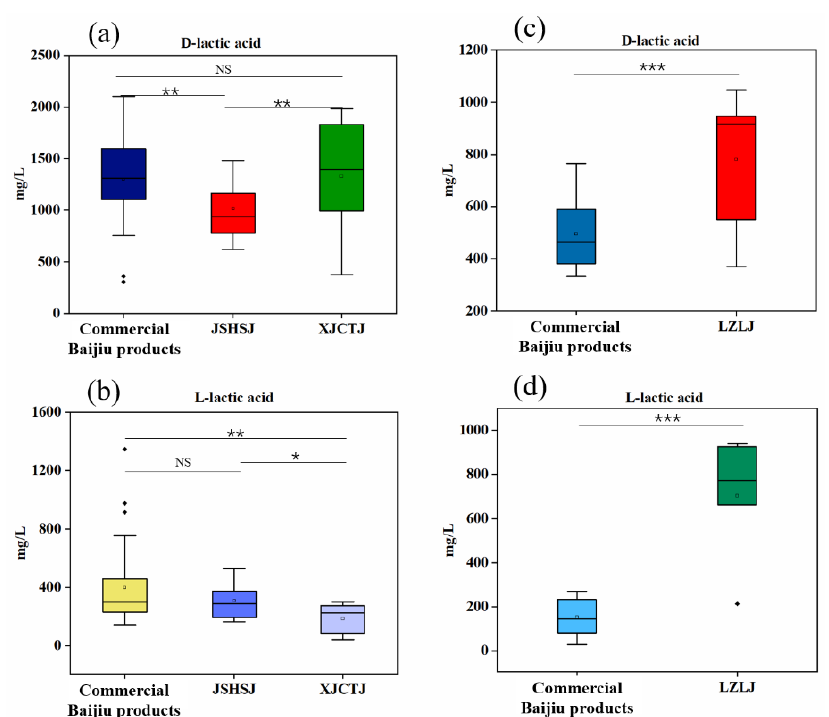
Figure 5. ( a , b ) Box plots of D-lactic acid and L-lactic acid contents in three different types of Baijiu (Commercial Baijiu products, JSHSJ, XJCTJ) in SSB; ( c , d ) box plots of D-lactic acid and L-lactic acid contents in two different types of Baijiu (Commercial Baijiu products, LZLJ) in STB. t-test: NS (not significant, p > 0.05); *: 0.01 < p < 0.05; **: 0.001 < p < 0.01; and ***: p < 0.001.